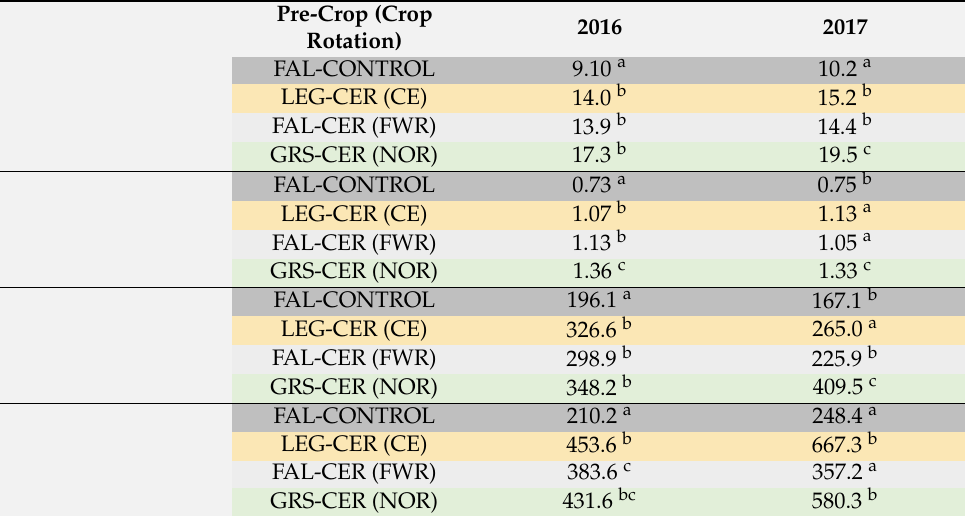
Table 1. The contents of organic carbon, total nitrogen, available phosphorus, and available potassium in soil for wheat crops in 2016 and